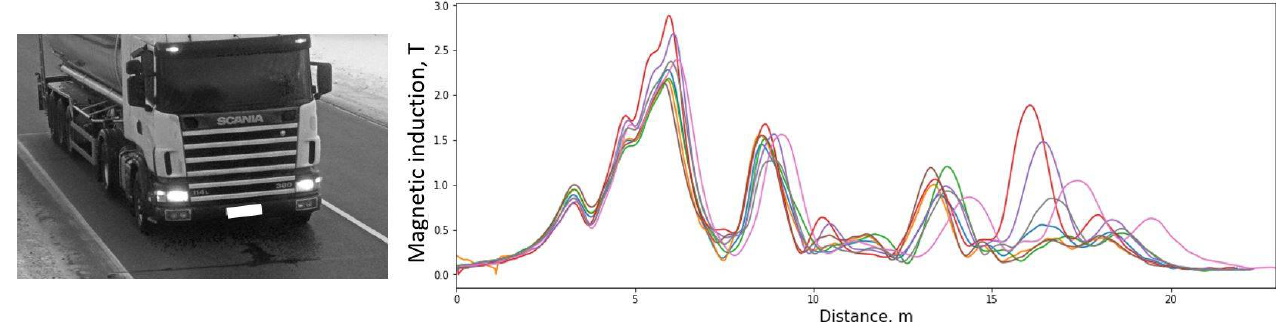
Figure 13. An example of a group of magnetic signatures produced by the same vehicle. Signatures rescaled according to the speed and aligned by the first peak. Table 1. Length estimation method result with the second dataset.